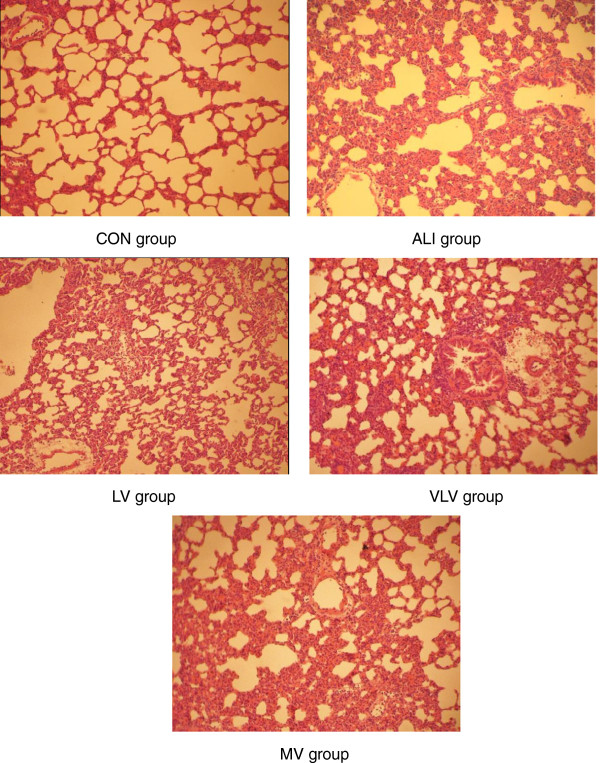
Lung Pathological Changes. Hematoxylin and eosin stain of representative lung tissue from rats subjected to CON=Control Group, ALI=Acute lung injury Group, LV=Low tidal volume Group, VLV=Very low tidal volume Group, MV=Large tidal volume Group. (magnification, ×200).